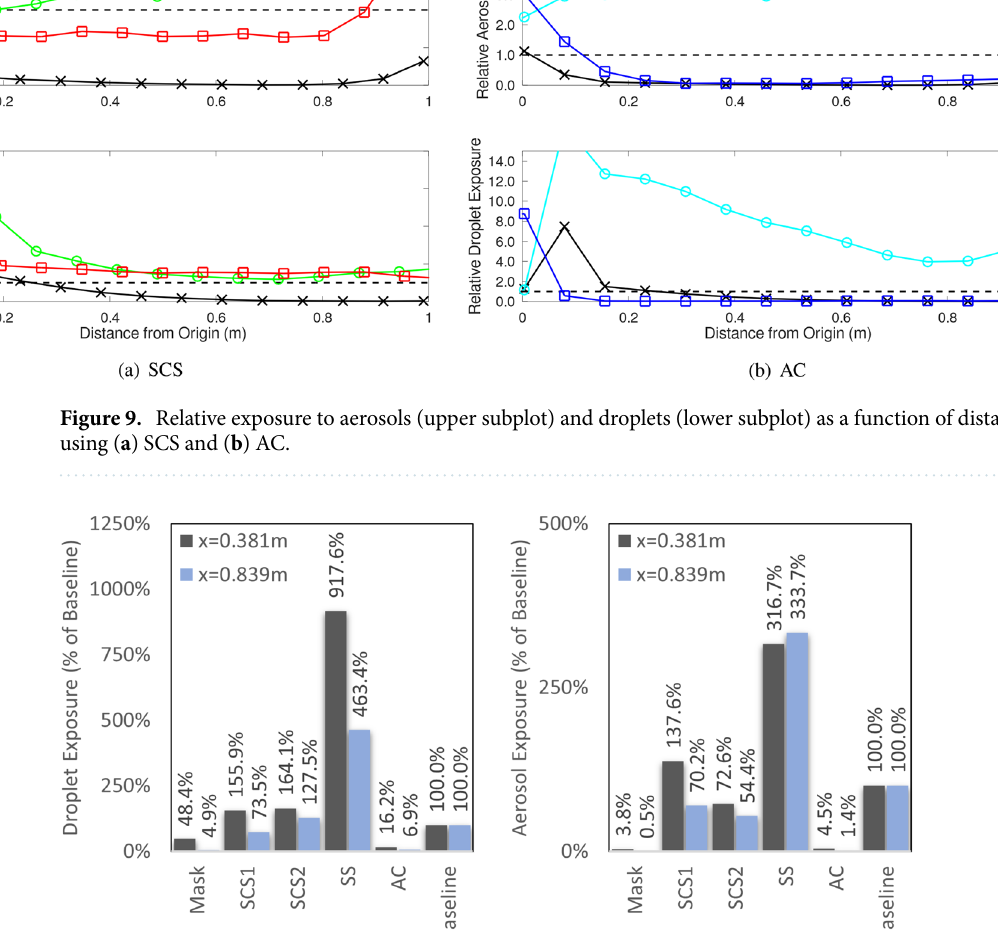
The experiments are based on high-speed flow diagnostics to quantify droplets and aerosols. The setup of the experiment involves a high-speed cameras and six light sources that are used to acquire measurements of a subject sneezing 14,33 . The images are captured at 5400 frames per second, with a total recording time of 1 s, and have a spatial resolution of 1.2 mm/pixel for a total span and height of 1230 × 1230 mm ( 5 × 5 ft). Each light source consists of a 750-W halogen bulb emitting light from 400 to 1800 nm with a peak at 750 nm(17). Three light sources are spaced equally along the horizontal distance above the region of interest pointed downward and the other three are below pointed upward. This allows for sufficient light scatter of the droplets exiting the subject’s nose and mouth with even illumination across the recording region of interest ( ± 7 of an intensity count). The light scatter allows for tracking of droplets through time. Removing geometric bias is also performed to account for the inability to control a position during a real human sneeze. The subject’s spatial location is marked with